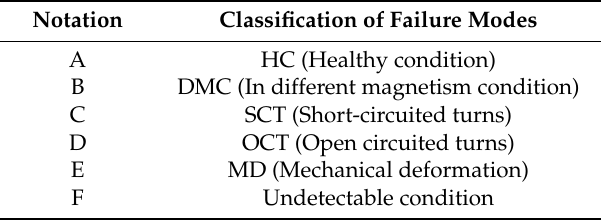
Figure 10. Flowchart of blocks. Table 2. Conditions of the hierarchical dimension reduction (HDR)